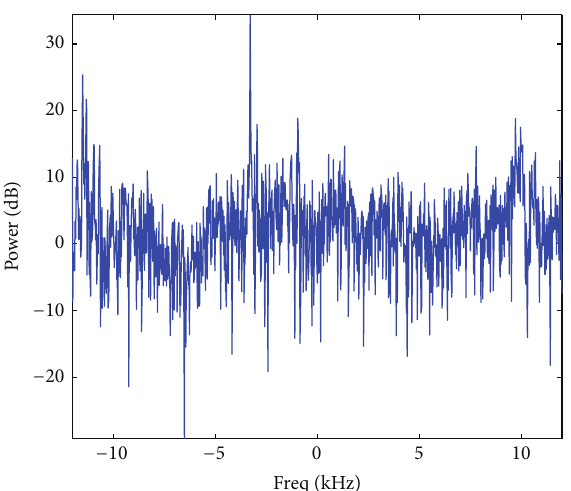
Figure 5: Frequency spectrum of time sample 58.